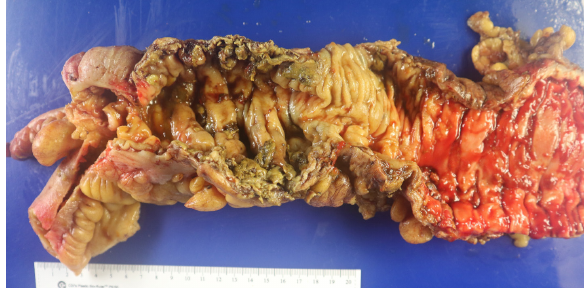
Figure 1: Gross image of the right colon with a single, deep, cratered, perforated ulcer (3.2 × 2.6 × 0.4 cm) with multi- ple additional smaller ulcers in the ascending colon (ranging from 0.3 to 1.3 cm).